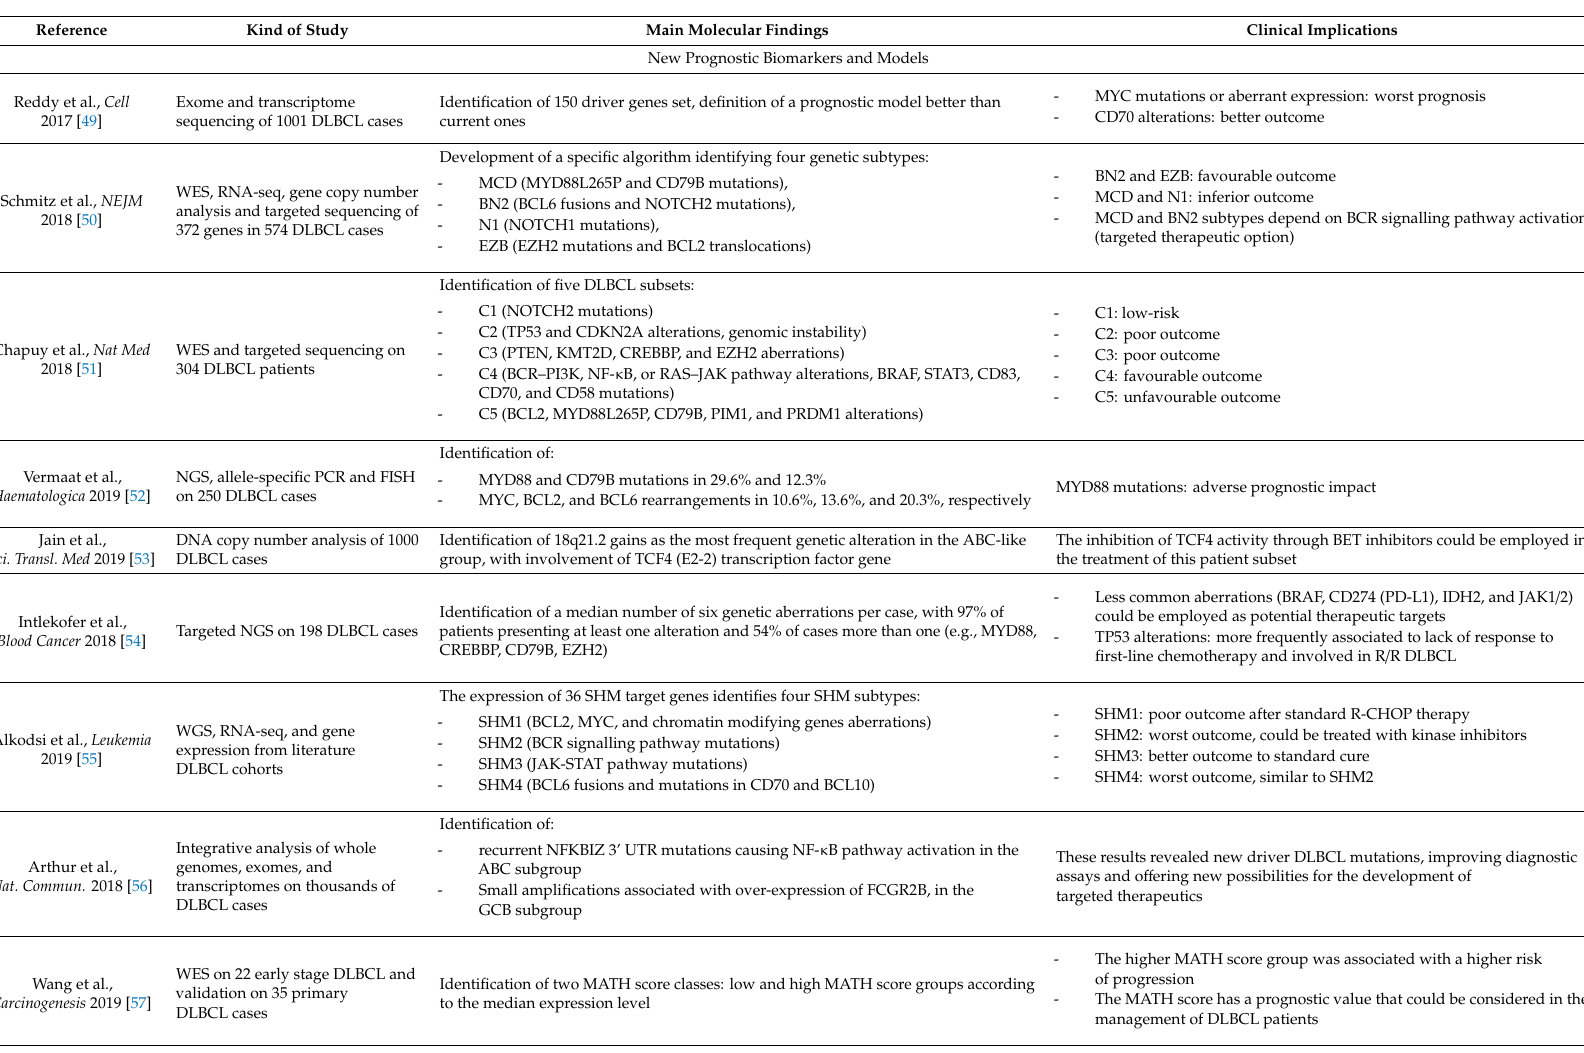
Table 1. Summary of the most relevant recent studies about DLBCL molecular classification and